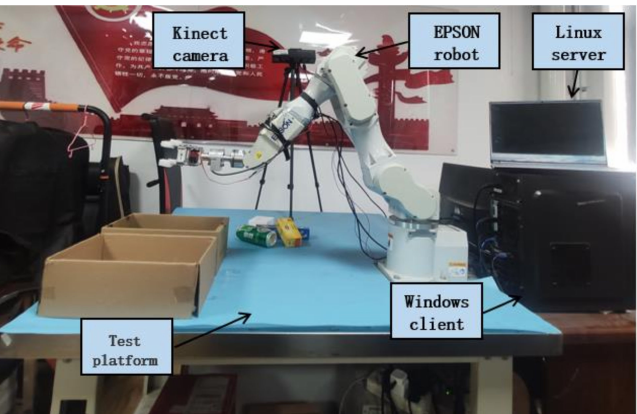
Figure 1. Sorting experimental platform.